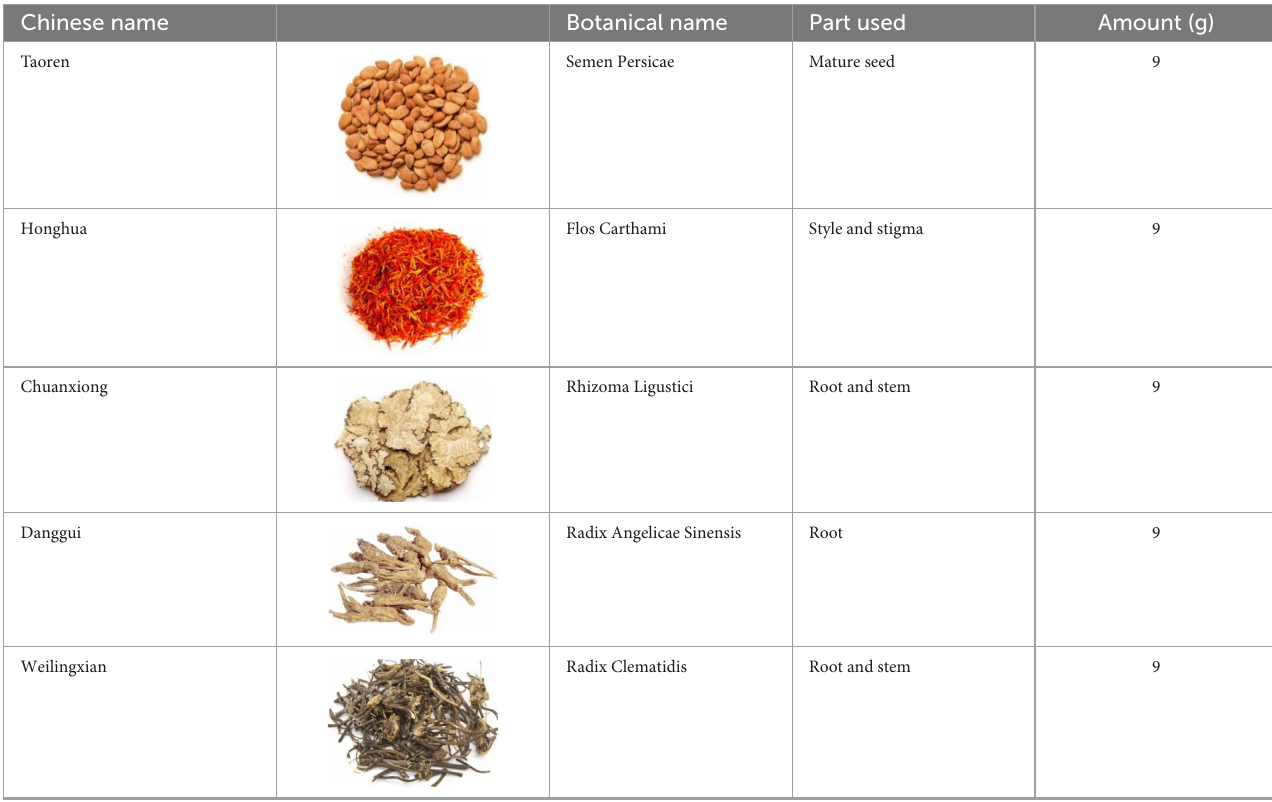
TABLE 1 Components of Tao Hong